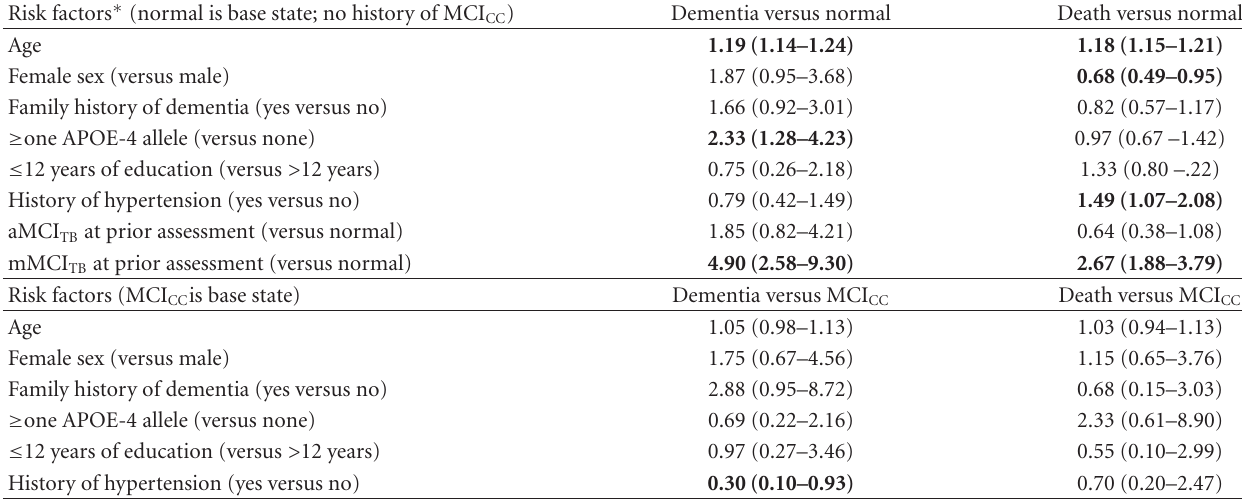
Table 5: Estimated relative risks and 95% confidence intervals for one-step transitions to dementia or death without dementia versus the base state of normal cognition or clinical consensus MCI (MCI CC ) (bolding denotes statistical